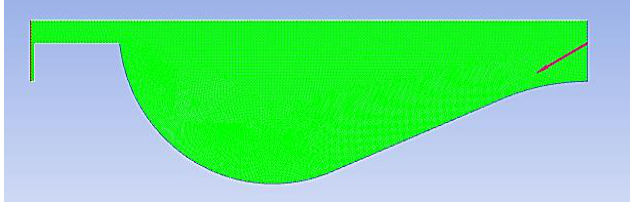
Figure 1. Mesh of one-sixth sector of cylinder and injection position.